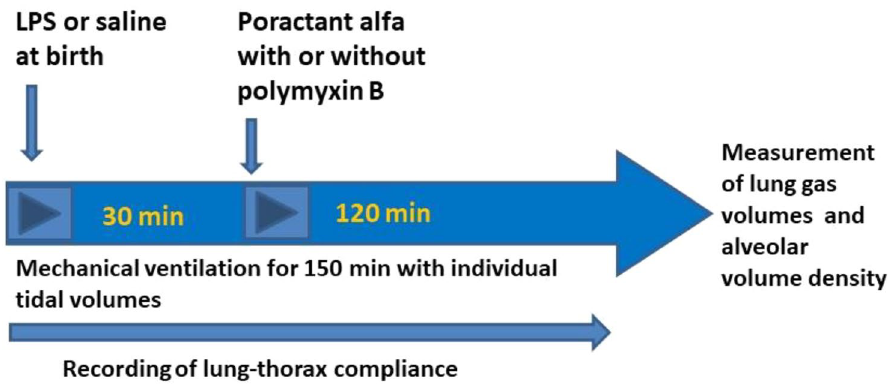
Figure 1. Schematic diagram of double-hit model of lung immaturity and acute lung injury by bacterial lipopolysaccharide (LPS) instillation in premature newborn rabbits and the overview of experimental